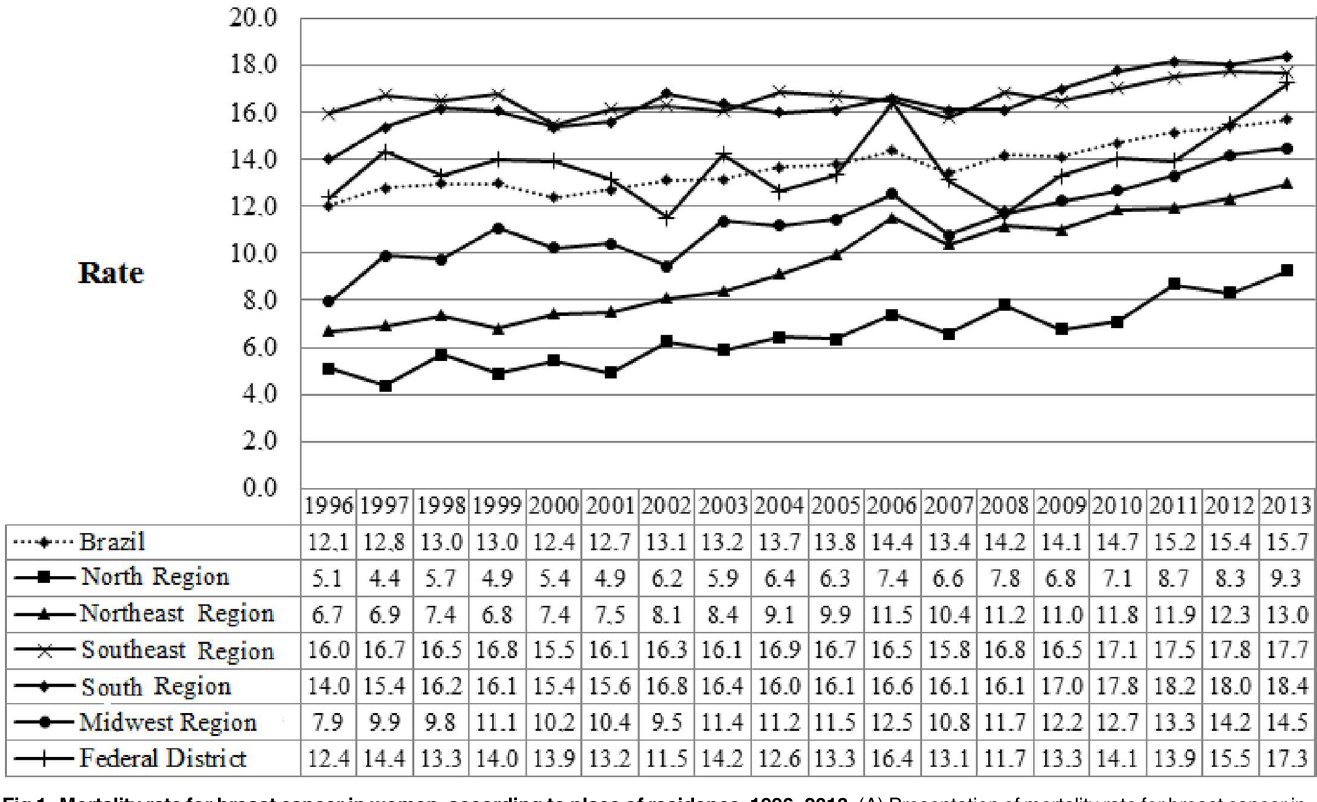
Fig 1. Mortality rate for breast cancer in women, according to place of residence, 1996–2013. (A) Presentationof mortality rate for breast cancer in Brazil and large regionsalong time periodof eighteen